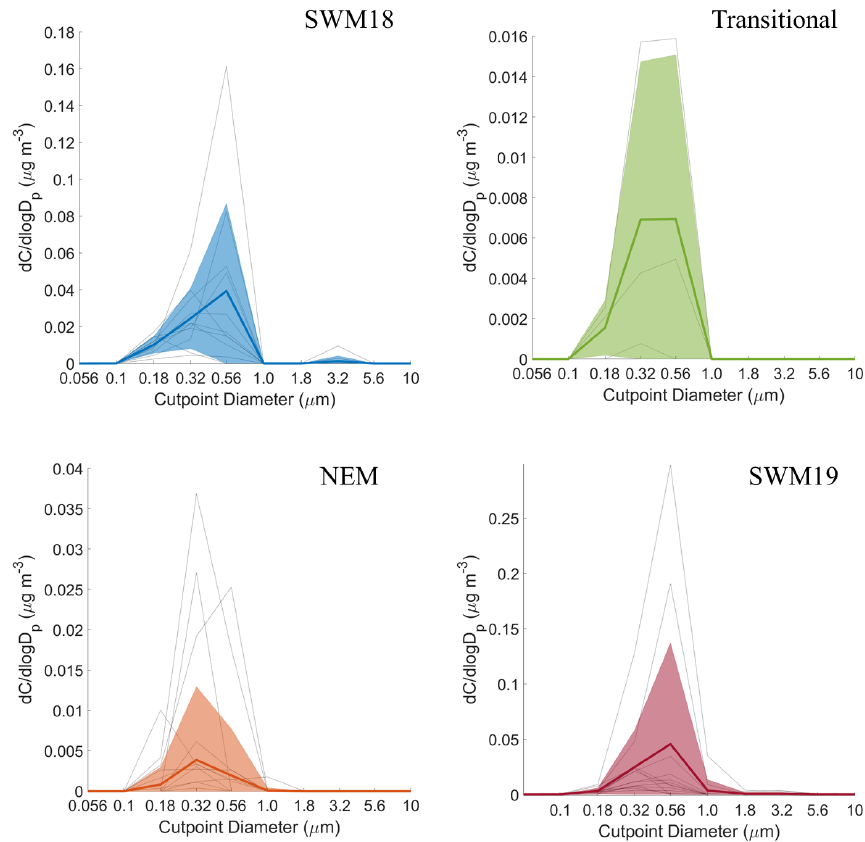
Figure 9. Same as Fig. 6 but for